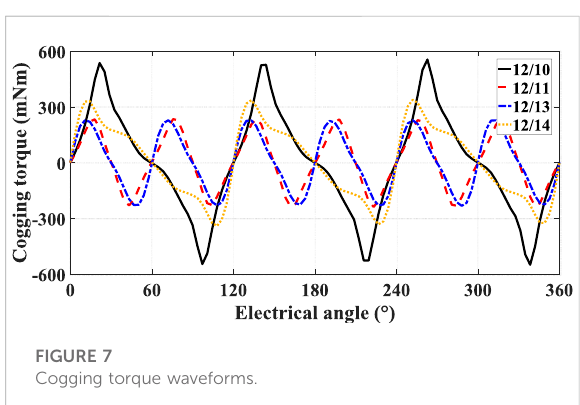
FIGURE 7 Cogging torque